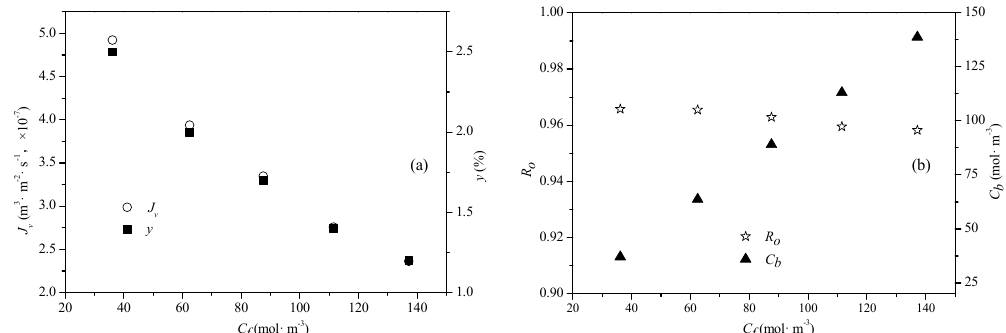
Figure 5. Influence of the feed solution concentration on RO process. ( a ) Solvent flux and recovery vary with feed solution concentration, feed solution flow ( Q f ) = 1.56 × 10 − 4 m 3 ·s − 1 , pH = 6, T = 306 K; ( b ) Solute rejection and retentate solution concentration vary with feed solution concentration, feed solution flow ( Q f ) = 1.56 × 10 − 4 m 3 ·s − 1 , pH = 6, T = 306 K.